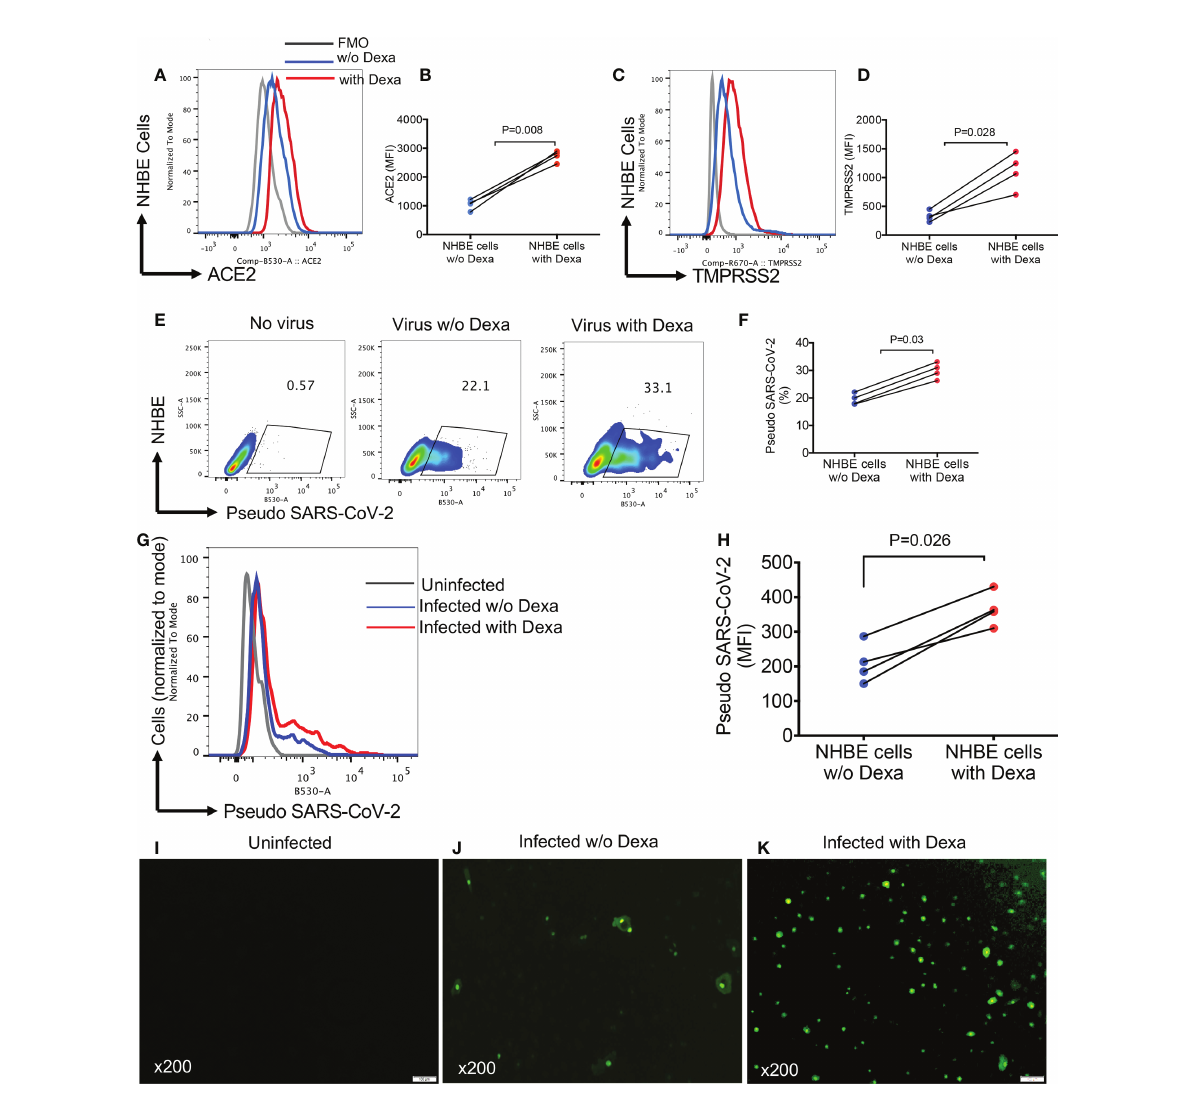
FIGURE 6 Dexamethasone treatment enhances the infectivity of NHBE cells to Pseudo SARS-CoV-2 infection. (A) Representative plots, and (B) cumulative data of ACE2 expression as measured by the mean fl uorescence intensity (MFI) in NHBE cells following overnight treatment with (0.5 µg/ml) or without dexamethasone treatment. (C) Representative plots, and (D) cumulative data of TMPRSS2 expression (MFI) in NHBE cells following overnight treatment with (0.5 µg/ml) or without dexamethasone treatment. (E) Representative fl ow cytometry plots, and (F) cumulative data showing percentages of NHBE cells untreated or treated with dexamethasone (0.5 m g/ml) and infected with the pseudo SARS-CoV-2. (G) Representative fl ow cytometry histogram plots, and (H) cumulative data showing the intensity [the mean fl uorescence intensity (MFI)] of pseudo SARS-CoV-2 infection in NHBE cells untreated or treated with dexamethasone (0.5 m g/ml). (I) Representative image of uninfected NHBE cells. (J) Representative images of dexamethasone untreated but infected NHBE cells with pseudo SARS-CoV-2. (K) Representative images of dexamethasone treated (0.5 µg/ml) and infected NHBE cells with pseudo SARS-CoV-2, magni fi cation x200. Error bars indicate mean ± SEM from at least two independent experiments. Each dot represents results from a single experiment. Dexamethasone (Dexa), w/o (without). Fluorescence minus one